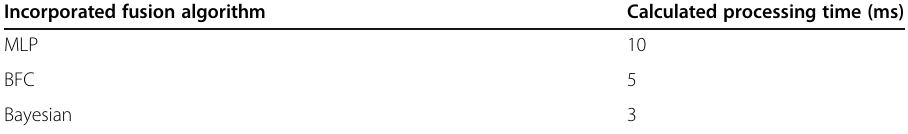
Table 3 The calculated processing time related to the proposed detection method as implemented using different fusion